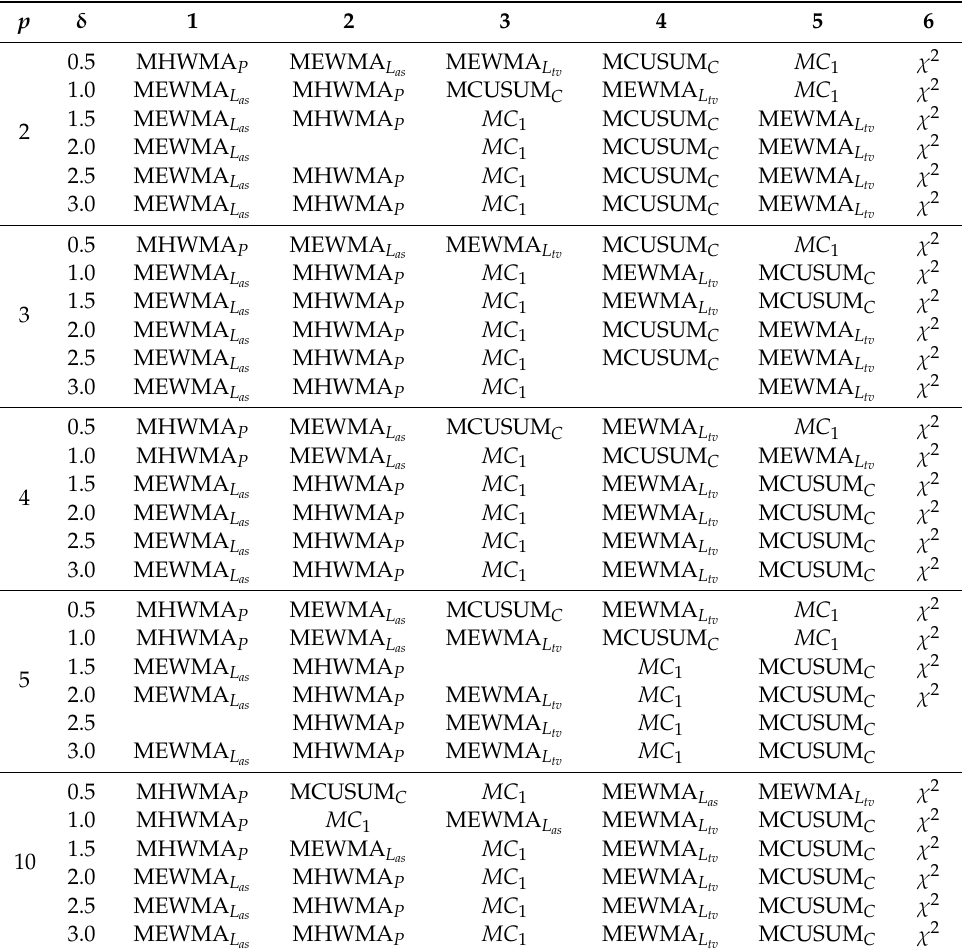
Table 4. Superiority order of multivariate charts at varying p and δ